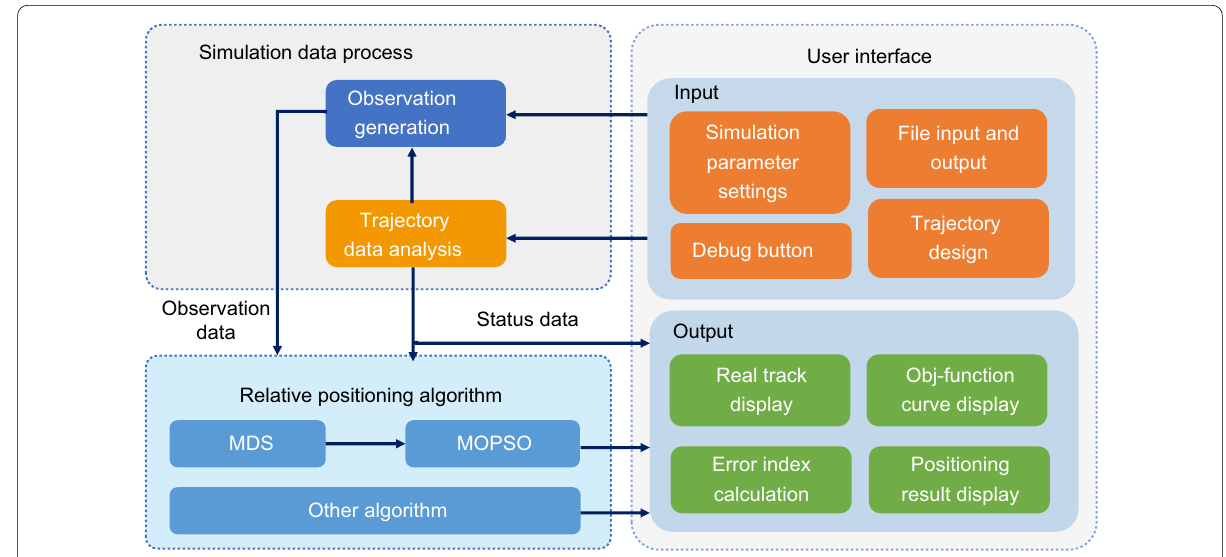
Fig. 5 Cluster positioning simulation platform